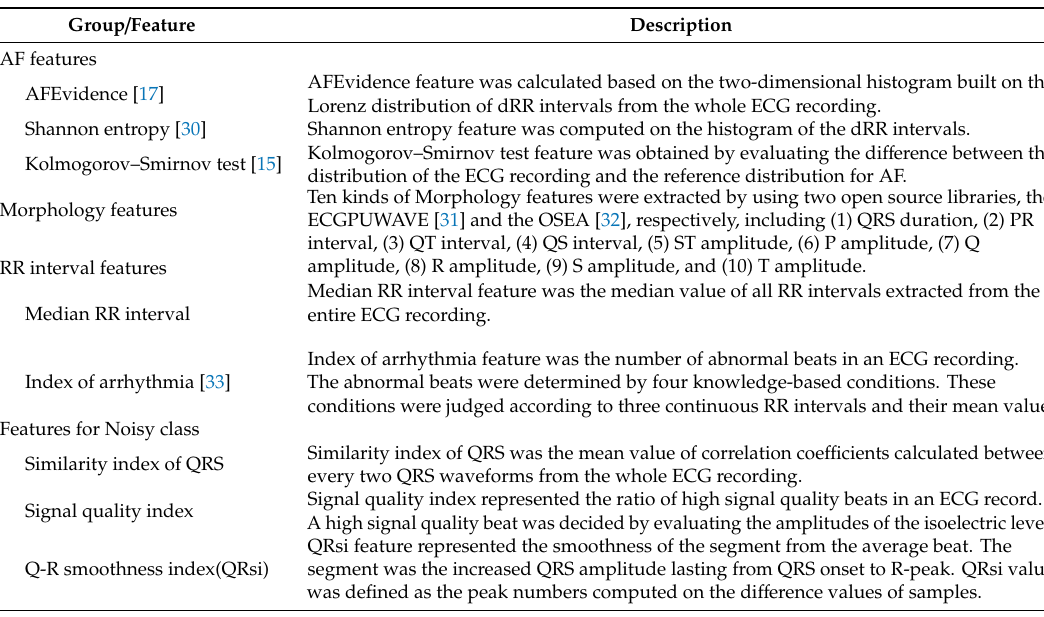
Table 2. Description of the key features.